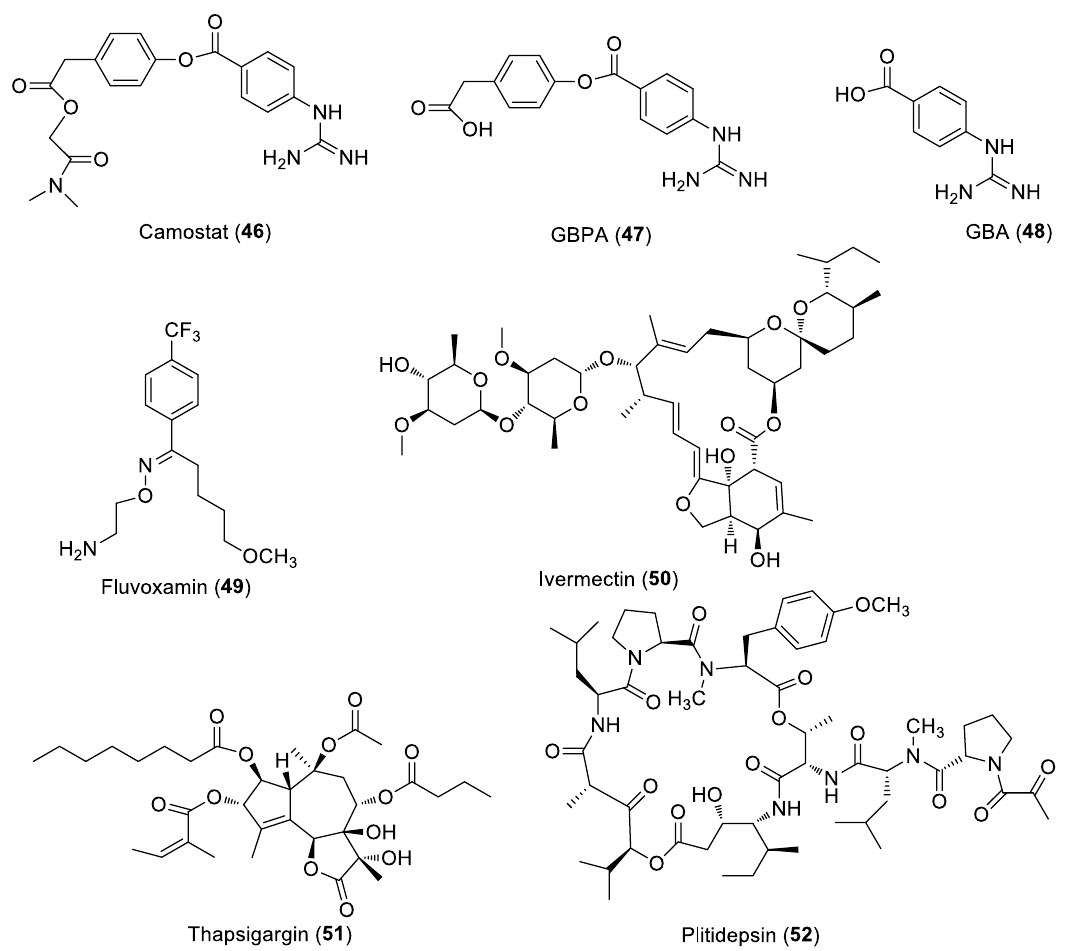
Figure 11. Host-based anti-SARS-CoV-2 agents.